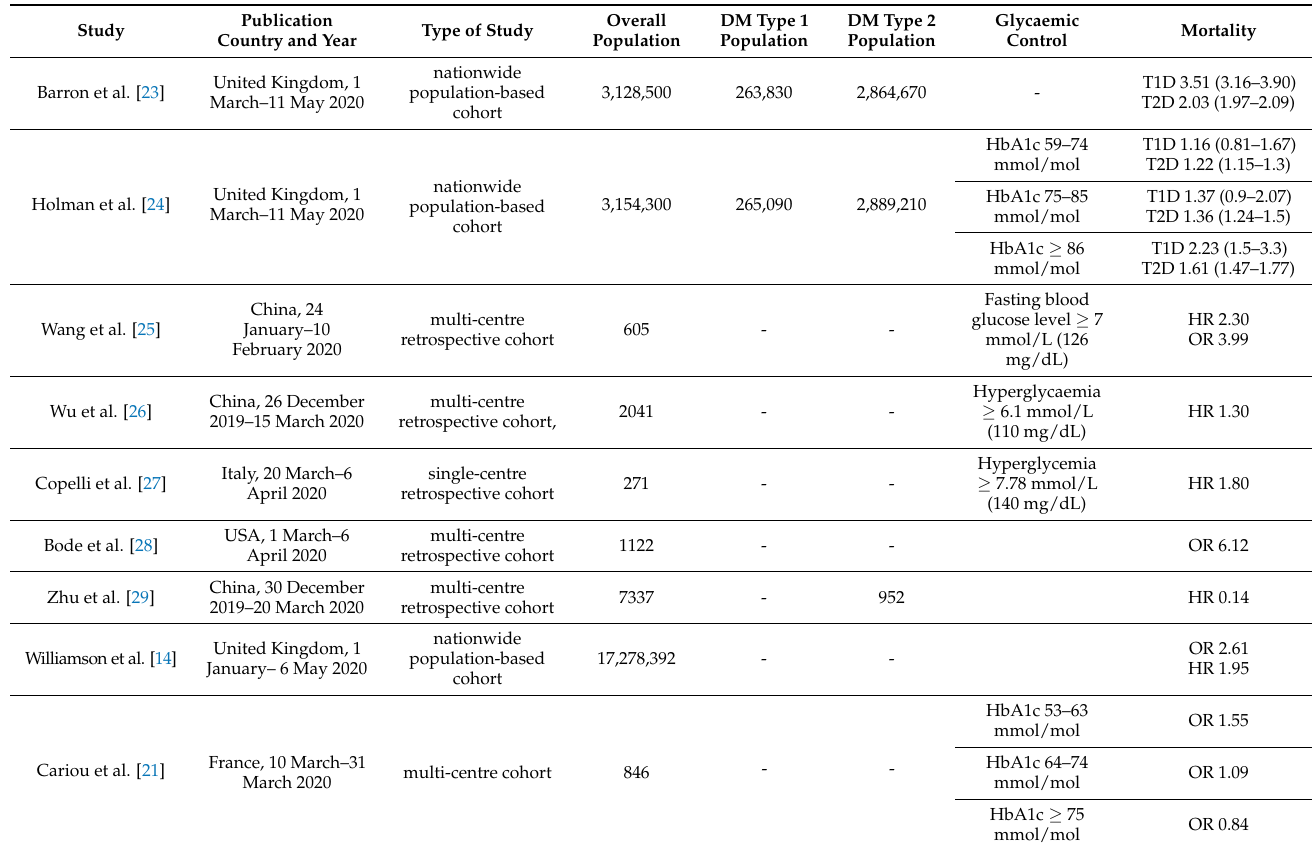
Table 1. Overview of risk regarding adverse COVID-19-related outcomes according to glycaemic